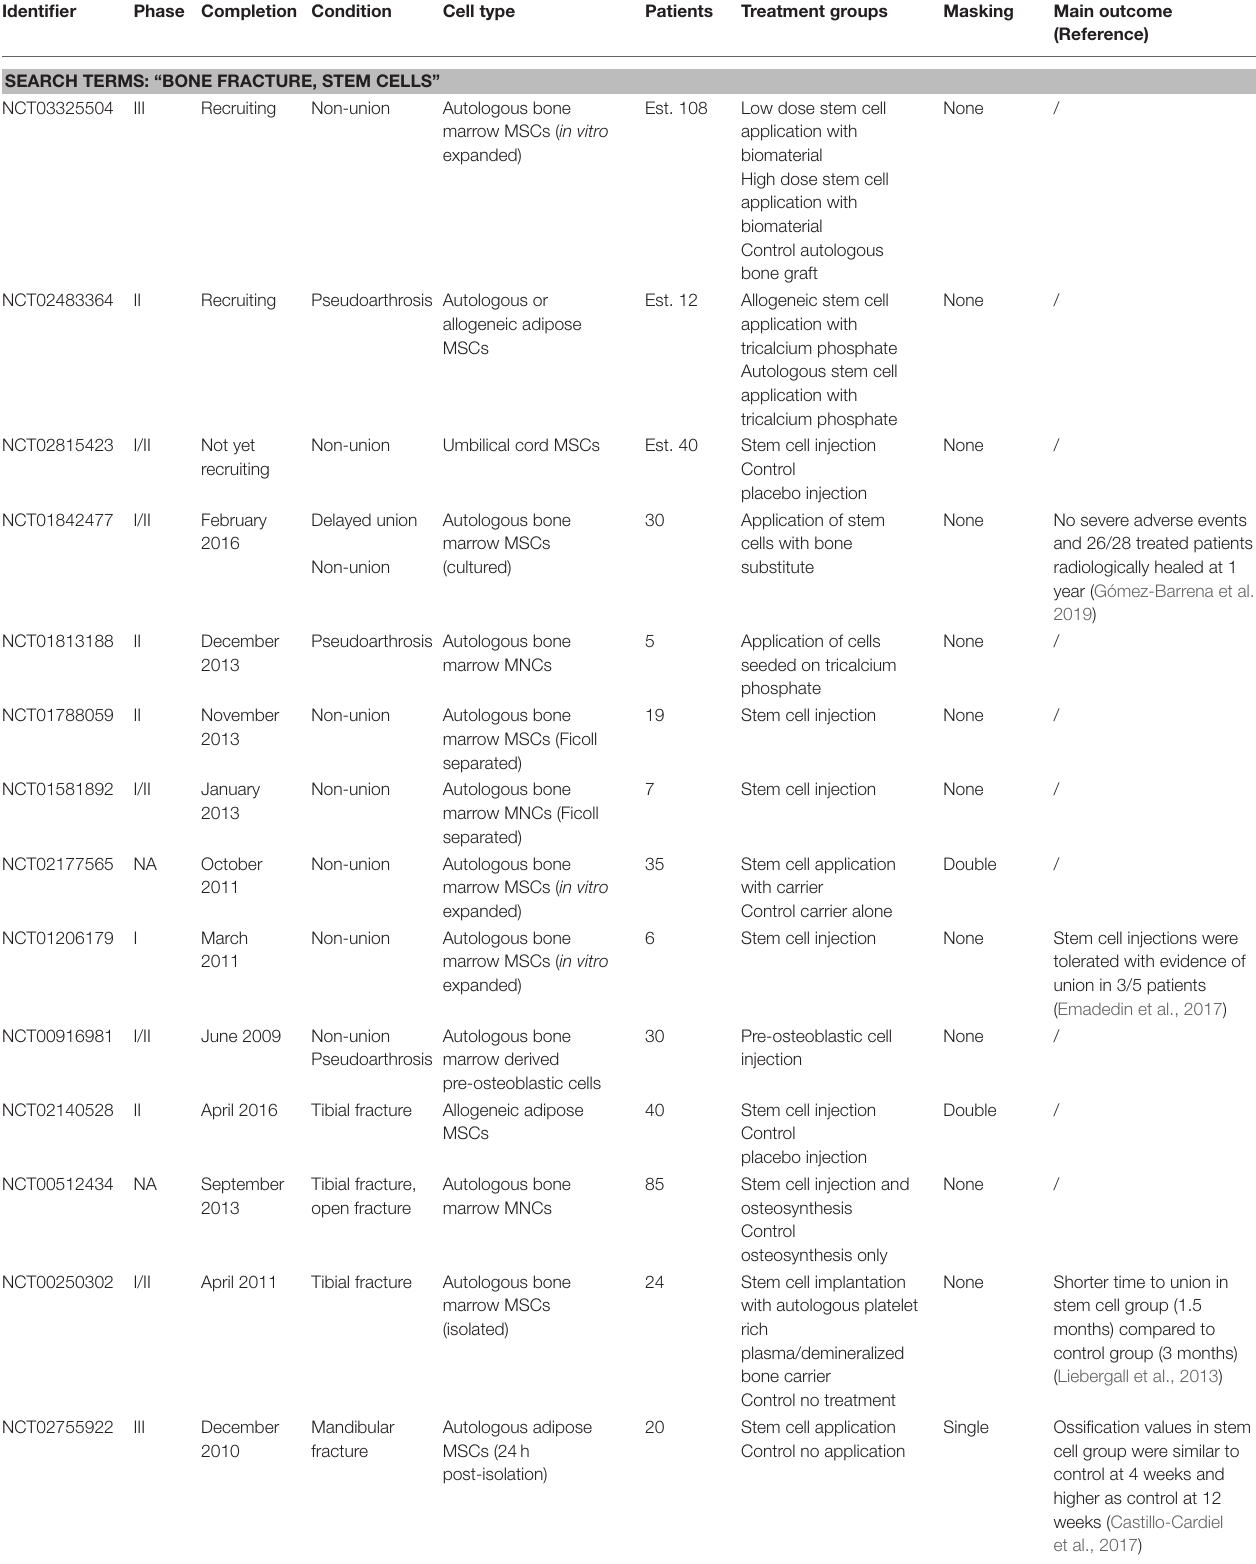
TABLE 1 | Clinical studies using MSCs and isolated progenitors for bone regeneration.